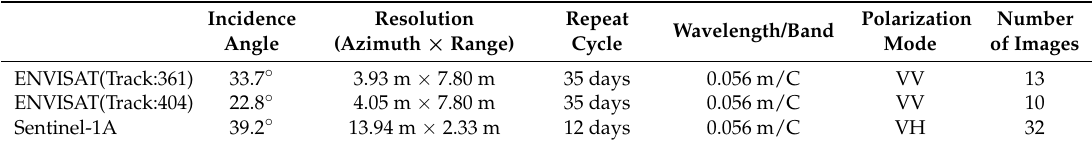
Table 1. Imaging parameters of SAR